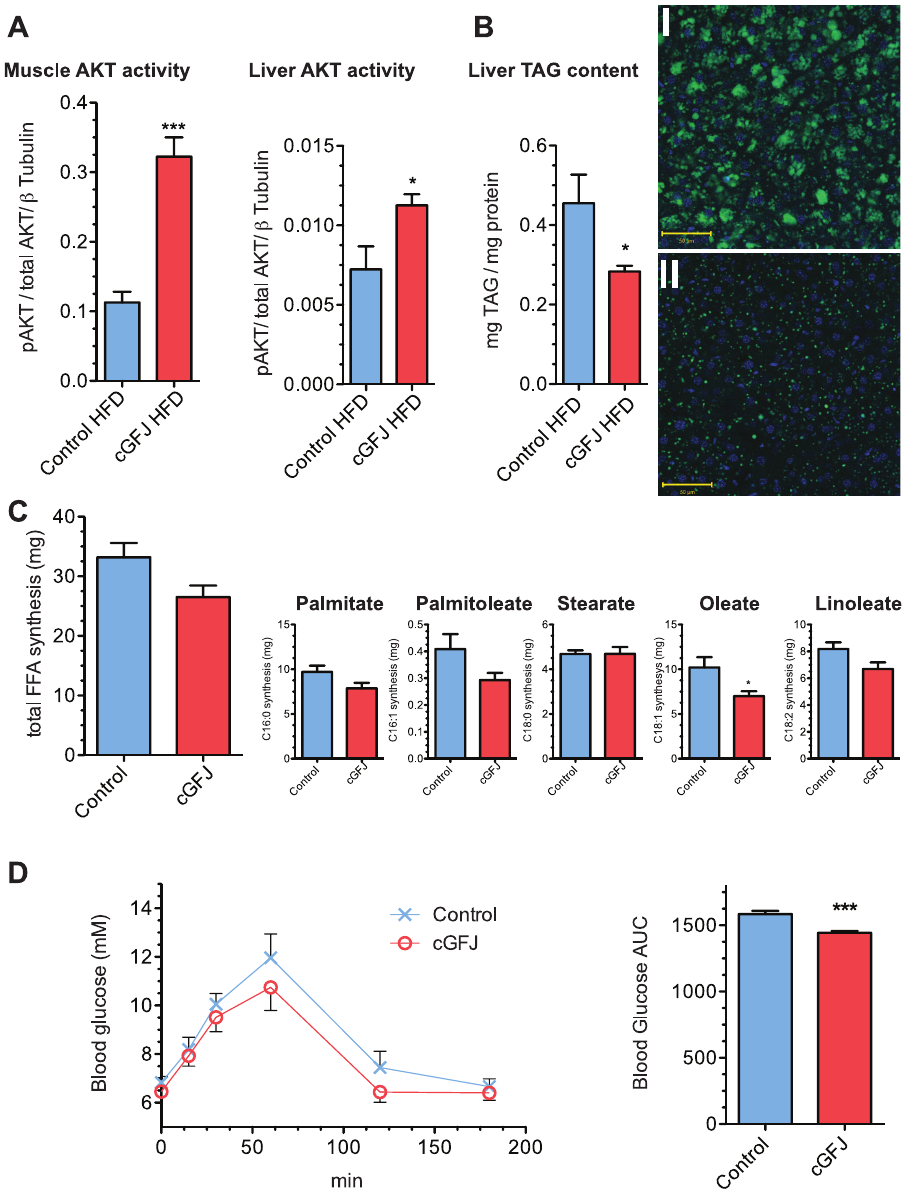
Figure 4. Impact of cGFJ on AKT activity in liver and skeletal muscle, TG content, and fatty acid synthesis. Mice were fed a HFD and 50% cGFJ for 100 d as described in the legend of Fig. 2. A) pAKT/total AKT ratios in muscle (*** P =0.0002) and liver (* P , 0.05); B) liver TG, * P , 0.05; I and II) Representative sections from control water and GFJ treated animals, respectively; C) total FFA synthesis and individual FFA; D) GTT and AUC at week 6, P , 0.005. A two tailed, unpaired t-test was used to determine statistical